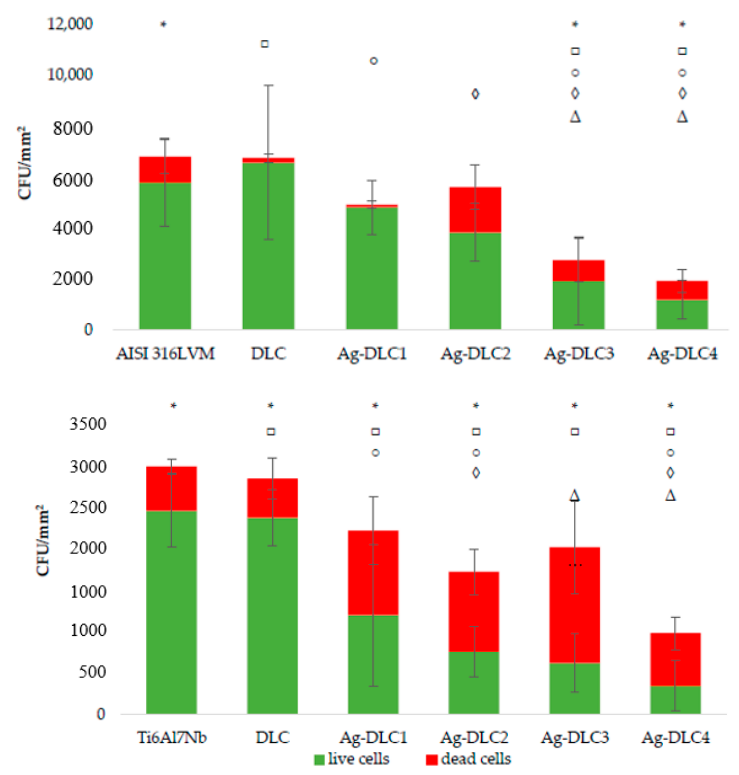
Figure 7. Assessment of microbial colonization of Escherichia coli on Ag-DLC coatings deposited on AISI 316LVM ( top ) and Ti6Al7Nb ( bottom ).